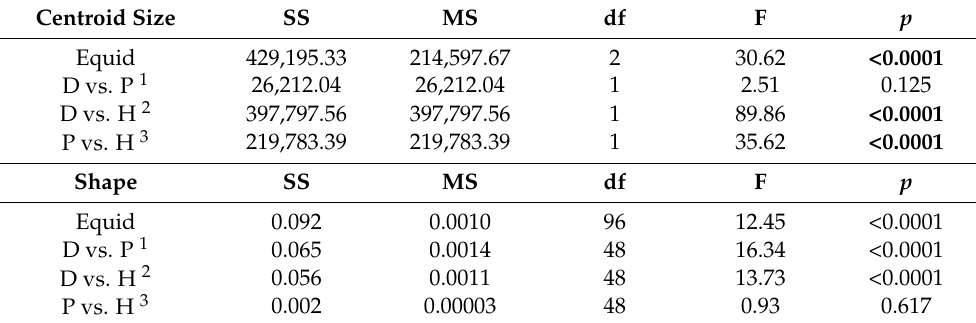
1 Comparison repeated after combination of donkey data set (D) and pony data set (P). 2 Comparison repeated after combination of donkey data set (D) and horse data set (H). 3 Comparison repeated after combination of pony data set (P) and horse data set (H).